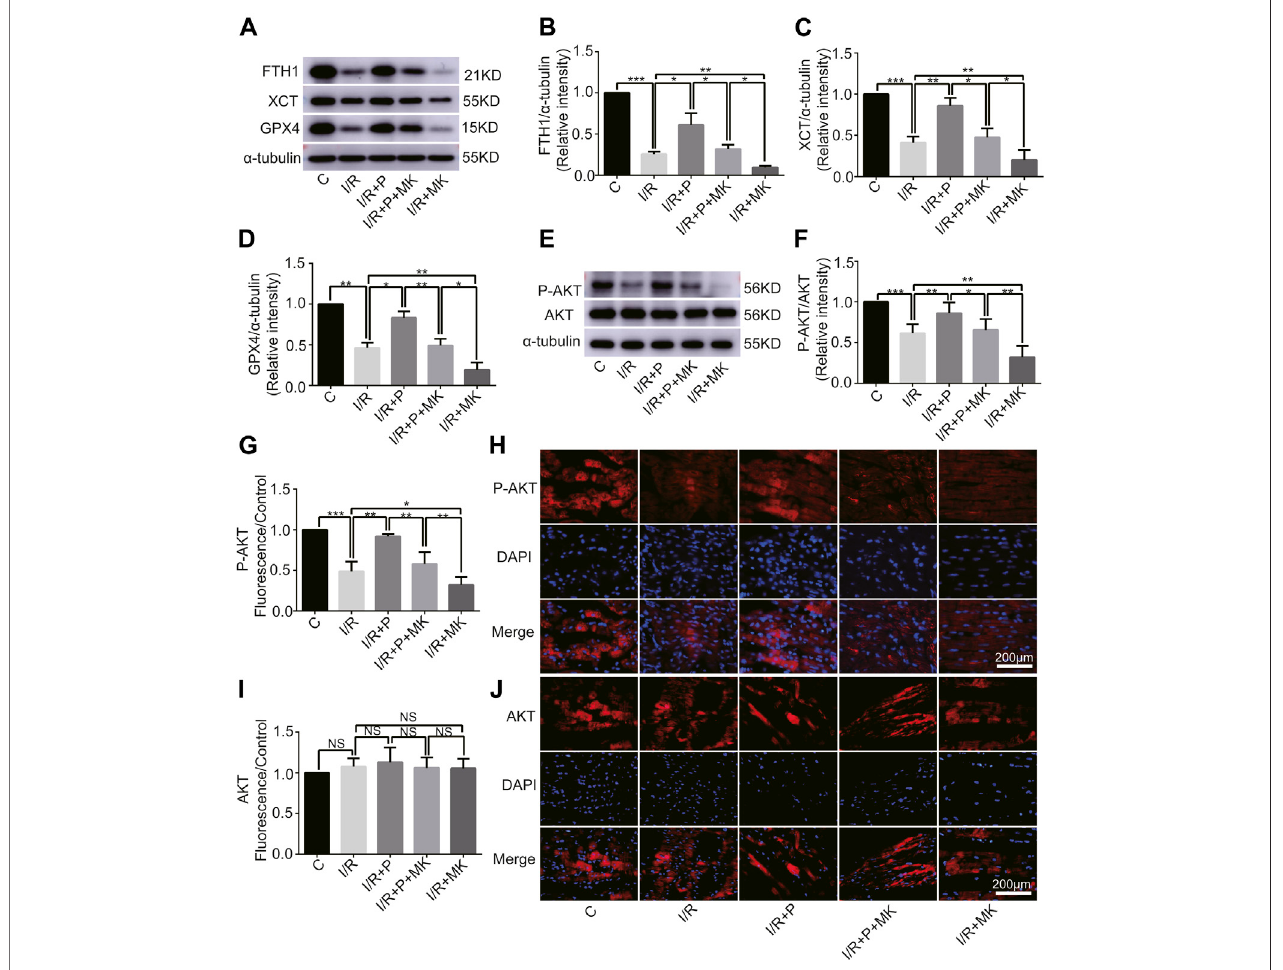
FIGURE 5 | Changes in protein levels in response to propofol. (A – D) : In fl uence of propofol on I/R-induced antioxidant enzyme expression. (E – F) . Expression of AKTandp-AKT inmyocardiumbasedonwesternblotanalysis. (G – J) .ExpressionofAKTandP-AKTbyimmuno fl uorescence.N=6.Dataareexpressed asthemean± SD. Scale bar: 20 µm. Signi fi cance was calculated using one-way ANOVA with Tukey ’ s post hoc test or the t -test. p -values < 0.05 were considered statistically signi fi cant. * p < 0.05, ** p < 0.01, *** p < 0.001.